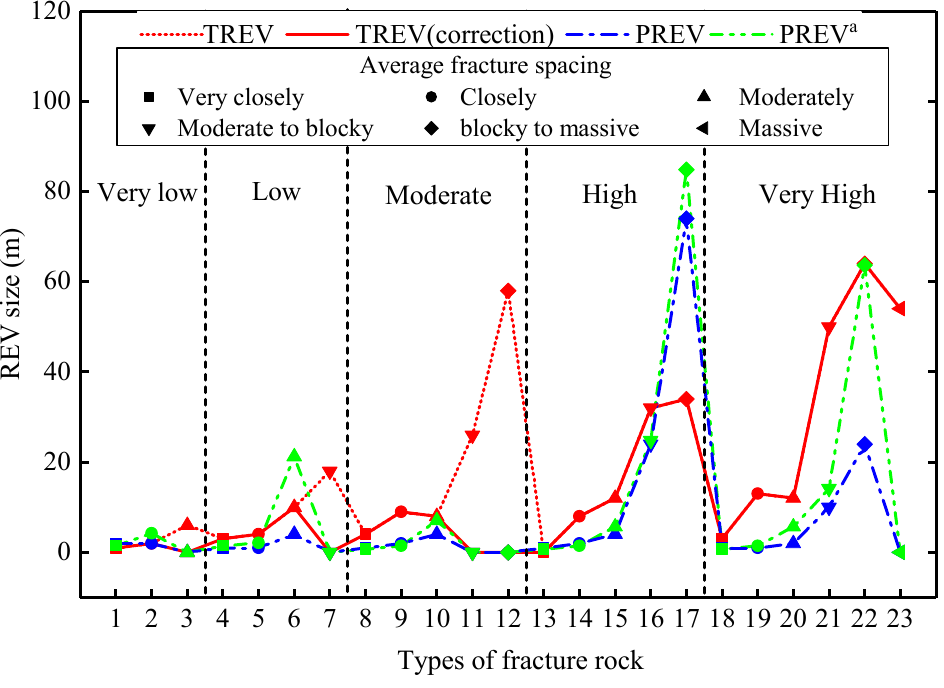
Figure 9. The REV of the fractured rock mass. The shape of the point indicates the fracture spacing, and the vertical bar area shows the fracture length. a After Zhang [33].